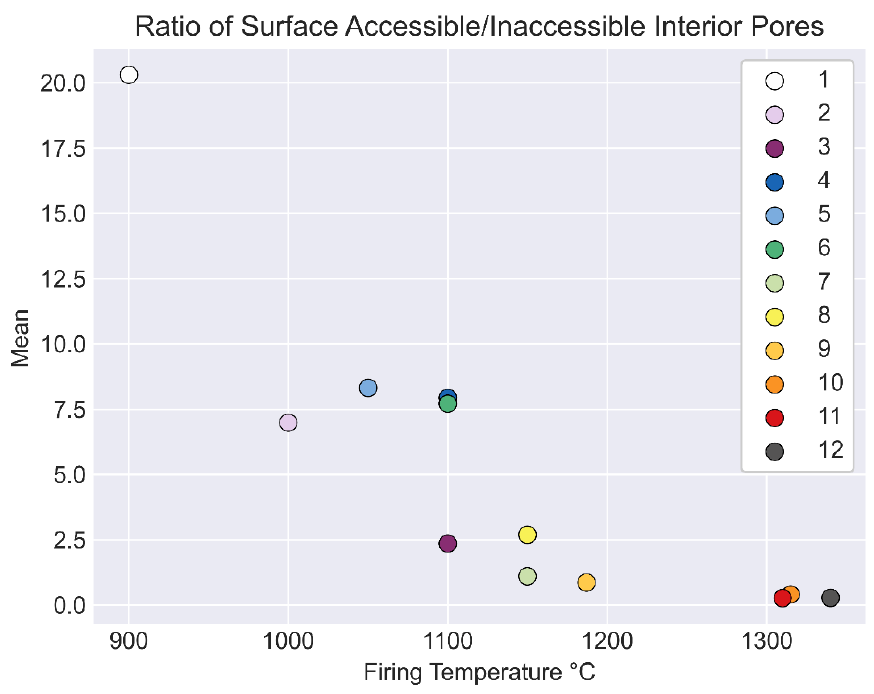
Figure 6. Ratio of pores that are accessible to any surface and the interior-only pores by firing temperature for each ceramic type (mean of 2).